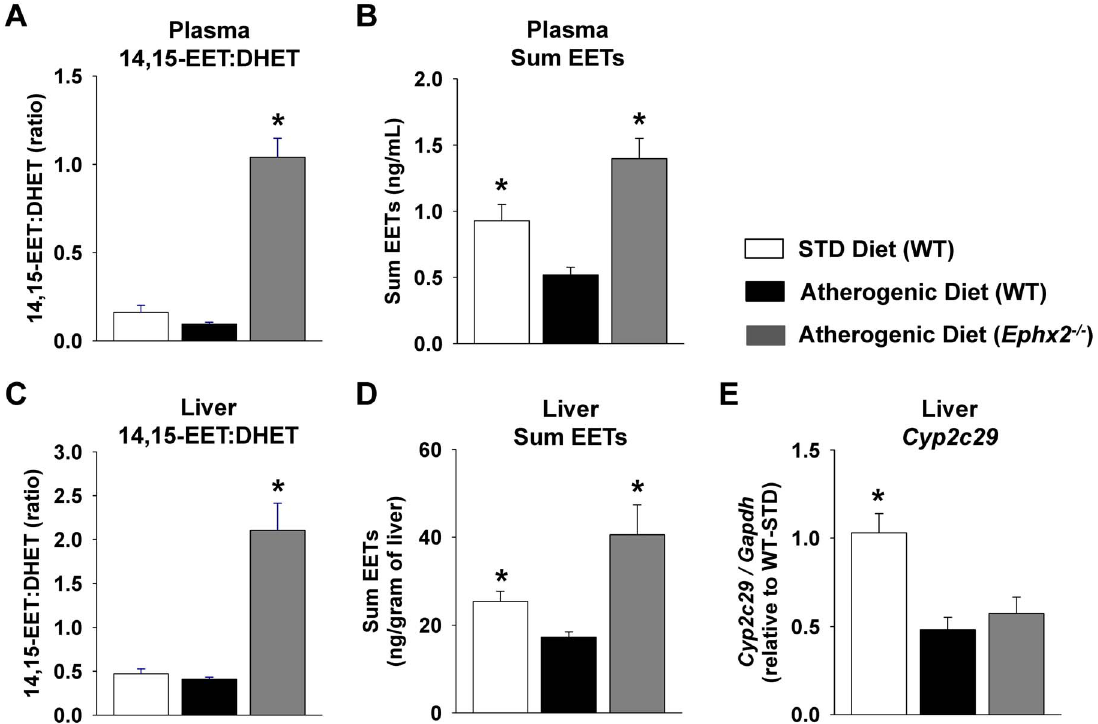
Figure 5. Genetic disruption of sEH-mediated EET hydrolysis increases circulating and hepatic EET levels. Plasma (n=10–19 per group) and liver (n=3–5 per group) eicosanoids were quantified in wild-type (WT) mice fed the STD diet and WT and Ephx2 2 / 2 mice fed the atherogenic diet. (A) Plasma and (C) hepatic 14,15-EET:DHET ratios (biomarker of sEH metabolic function [lower ratio indicative of higher function]) and (B) plasma and (D) hepatic sum EET levels were significantly higher in atherogenic diet fed Ephx2 2 / 2 compared to WT mice. (E) Liver Cyp2c29 expression (n=10– 19 per group) was significantly suppressed in both WT and Ephx2 2 / 2 mice fed the atherogenic diet. *P , 0.05 vs. WT atherogenic diet group.